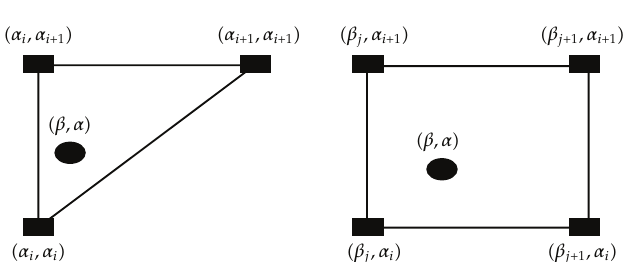
Figure 10: Calculation of F (cid:2) α,β (cid:3) in the postprocessing stage of numerical Preisach model by interpolation